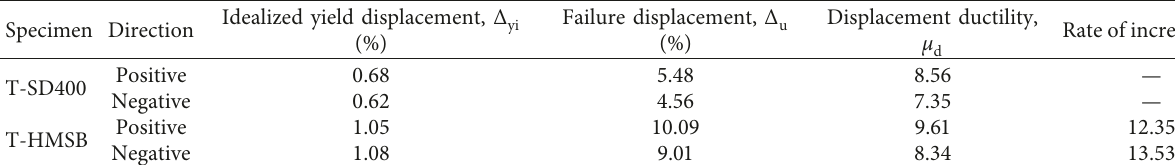
Figure 13: Displacement ductility calculation: (a) T-SD400 and (b) Table 3: Summary of displacement ductility calculation.